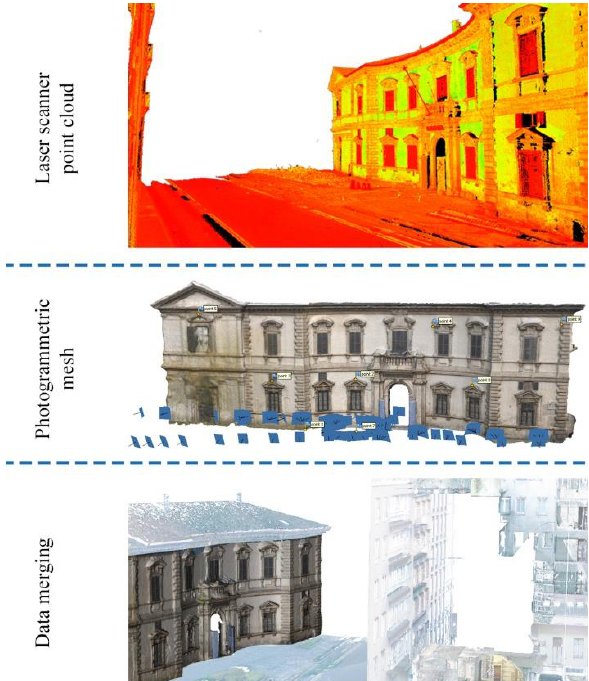
Figure 8 . The primary data sources used for the model generation of the Senate